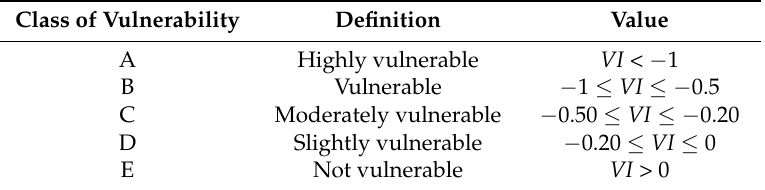
Table 5. Classes of reservoir vulnerability to climate change, definitions, and